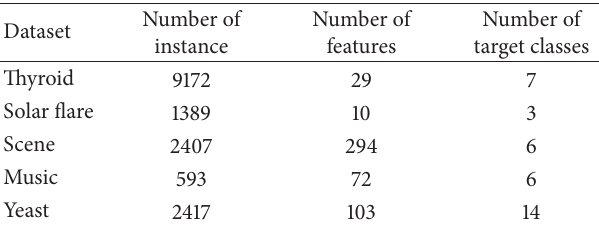
Table 2: Evaluation metrics for J48 algorithm.